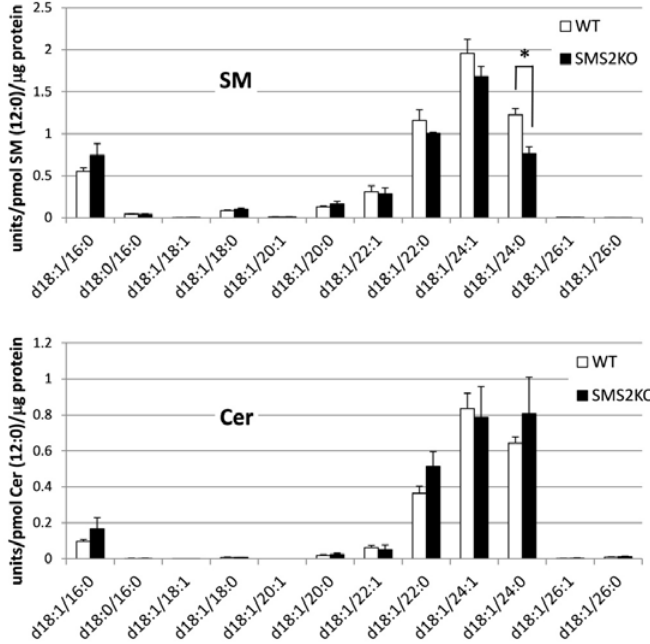
Figure 3. Differences in the levels of sphingolipid, GPL and DAG molecular